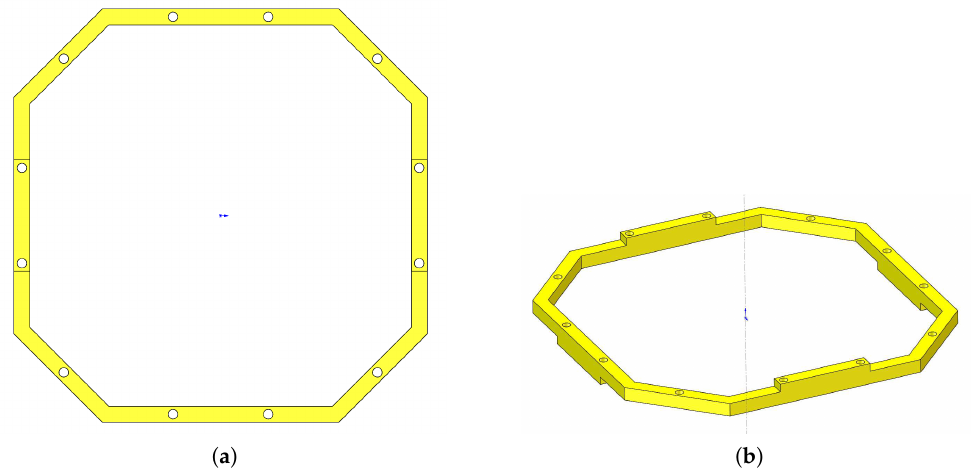
Figure 3. Illustrations of ( a ) top view and ( b ) overview of the platform.